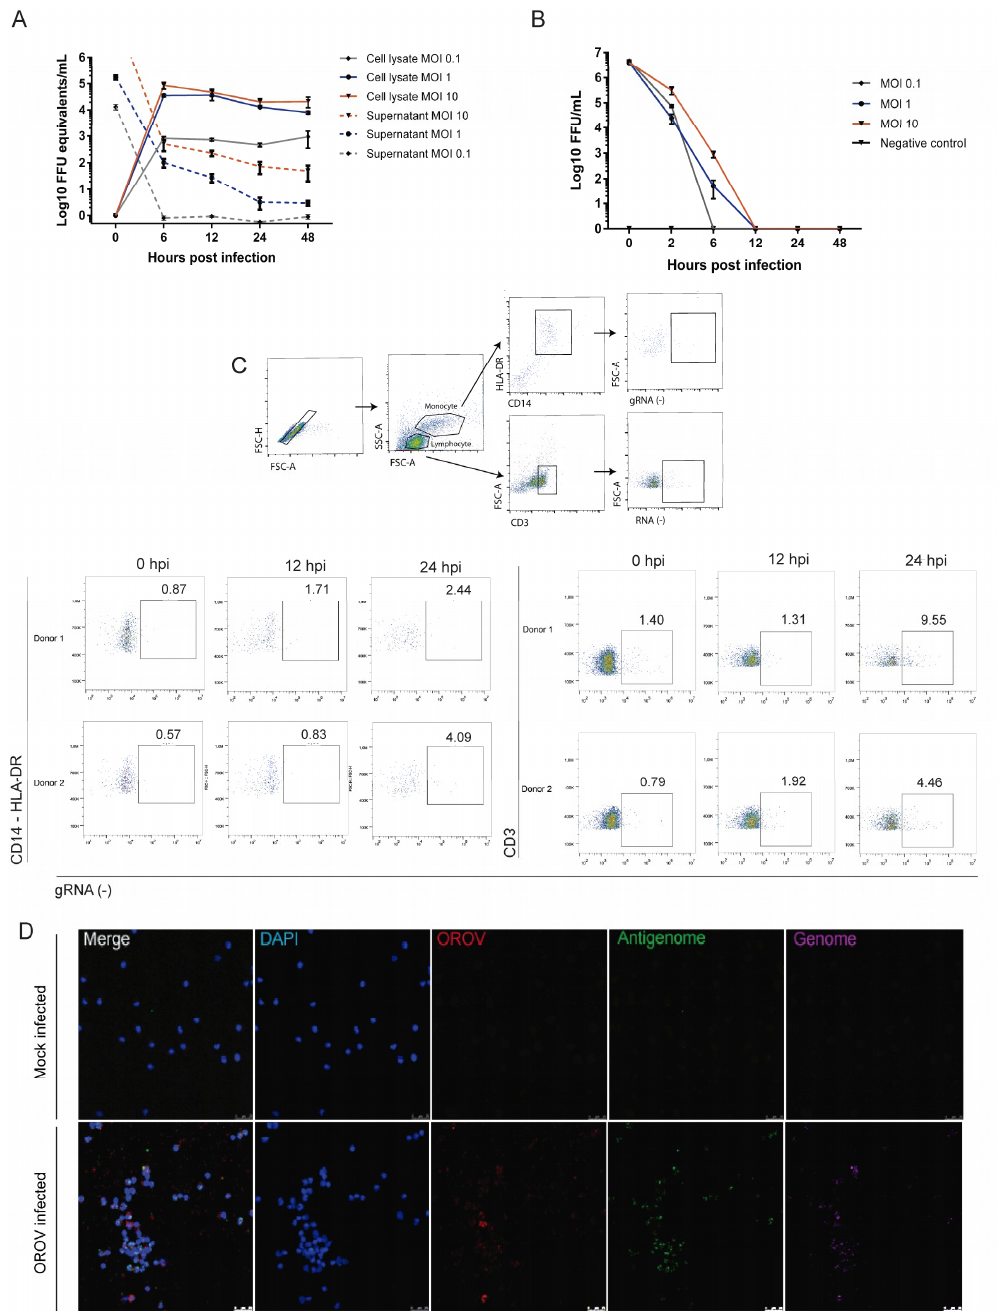
Figure 3. Human peripheral blood monocytes and lymphocytes are susceptible to OROV infection but Figure 3 generate low yields of infectious particles. Human peripheral blood mononuclear cells (PBMCs) were obtained from whole blood of healthy donors, infected in vitro and analyzed by di ff erent methodologies. ( A ) PBMCs were seeded in 24-well plates and infected with OROV MOI 0.1; 1 and 10. Cell lysates and supernatants were collected to RNA quantification by qRT-PCR ( n = 3). ( B ) The supernatants were also analyzed by FFA assay. Symbols represent the mean of viral load ± SEM. ( C ) PBMCs from healthy donors ( n = 2) were infected with MOI 1, submitted RNA PrimeFlow ™ protocol 24 hpi and flow cytometry. CD3 + and CD14 + HLA DR + percentage of events with OROV Grna, and the gating strategy are shown. ( D ) Detection of OROV 48 hpi in cells infected with MOI 2, by confocal microscopy. OROV proteins in red (Alexa Fluor 594); genome (gRNA) in magenta (AlexaFluor 647); antigenome (agRNA) in green (AlexaFluor 488); DAPI (blue). Images with 63x times magnification. Scales at 25 µ